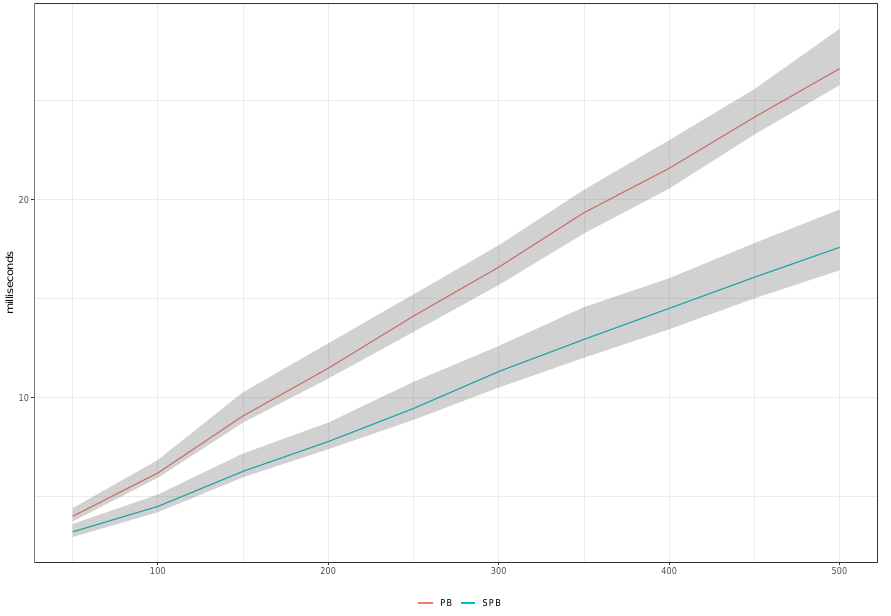
Figure 2. Plots of the median computational cost of the semiparametric (blue line) and parametric (red line) bootstrap procedures ( B = 999), computed through Monte Carlo replications, with increasing sample size. Upper and lower bands of the grey area represent the 2.5 and the 97.5 quantiles of the distribution of the computational